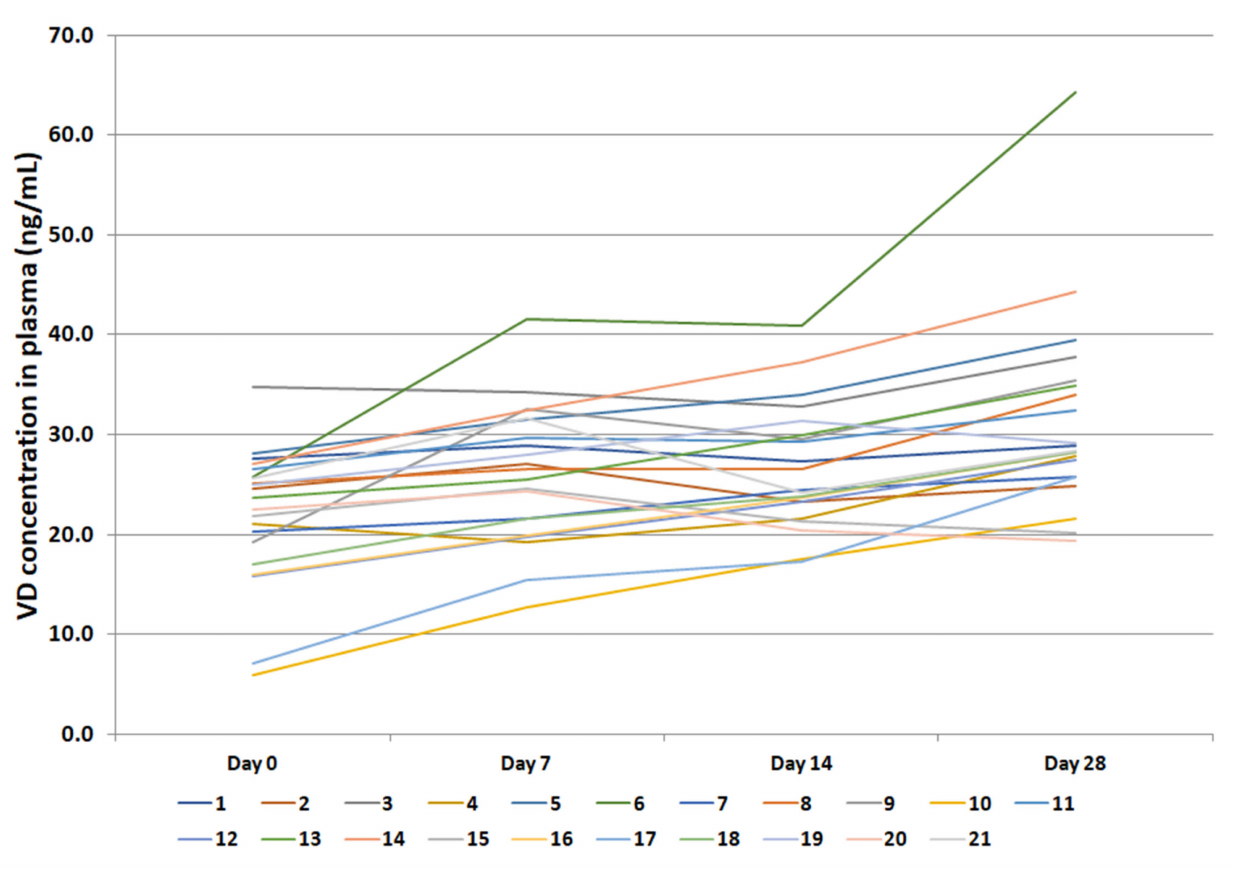
Figure 1. Overview of patient’s results in terms of monthly vitamin D (VD) increase following oral supplementation with 2000